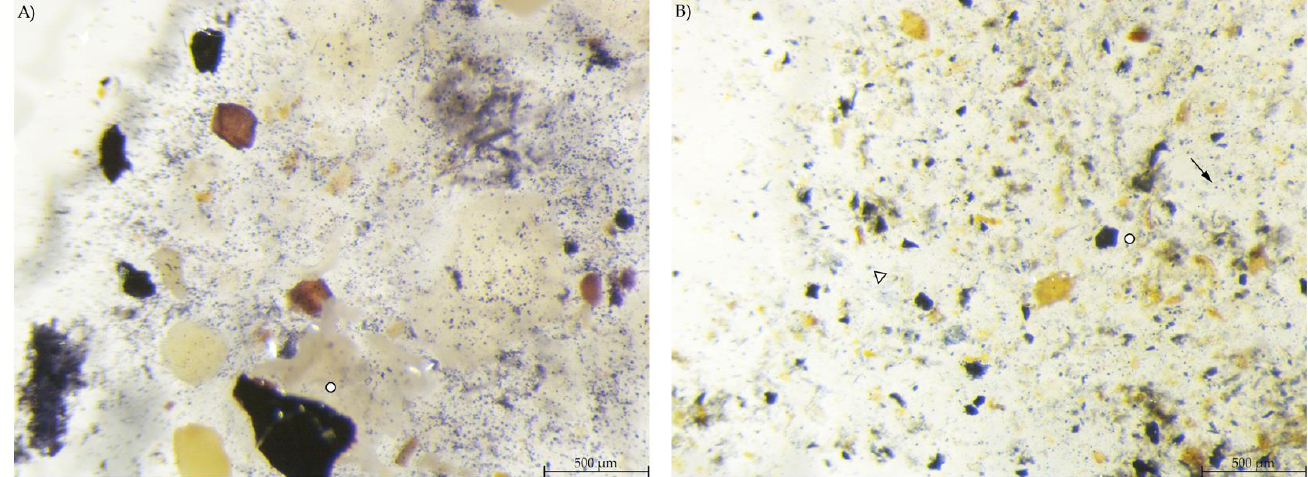
Figure 5. Stomach content samples stained with Lugol ’ s iodine. ( A ) PEL with compact, round stained starch particles; ( B ) EXT with round and irregular stained particles and a blue haze in the fluid phase (stereomicroscopy, 25 ×; ○ marking larger starch fragments, ↓ marking small round particles, ∆ marking blue haze).